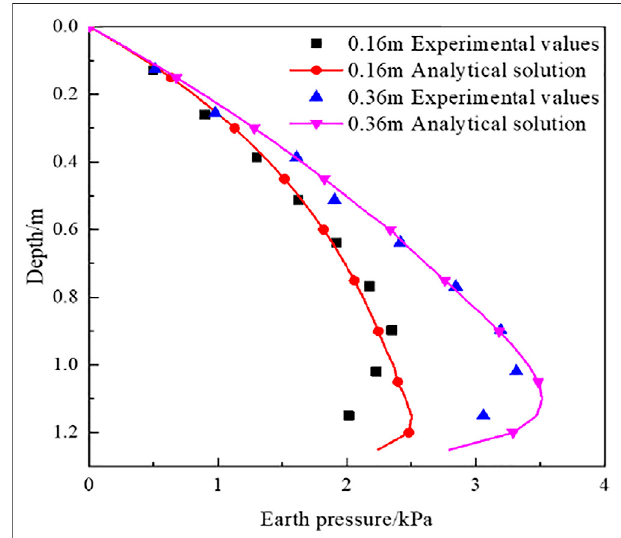
FIGURE 8 | Comparison of lateral earth